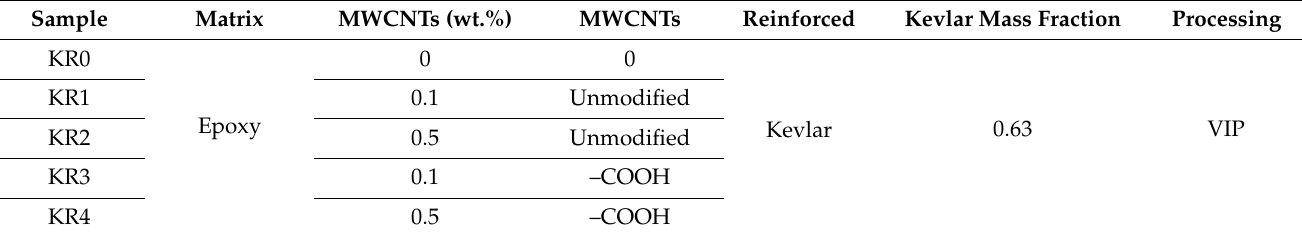
Table 4. Specification of Kevlar/epoxy MWCNTs nanocomposites